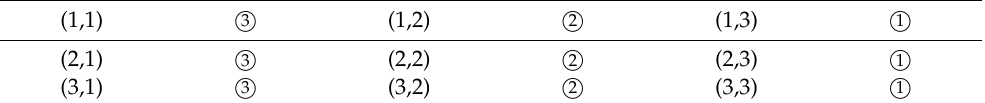
Table 3. Moves along (1,3) → (1,1).